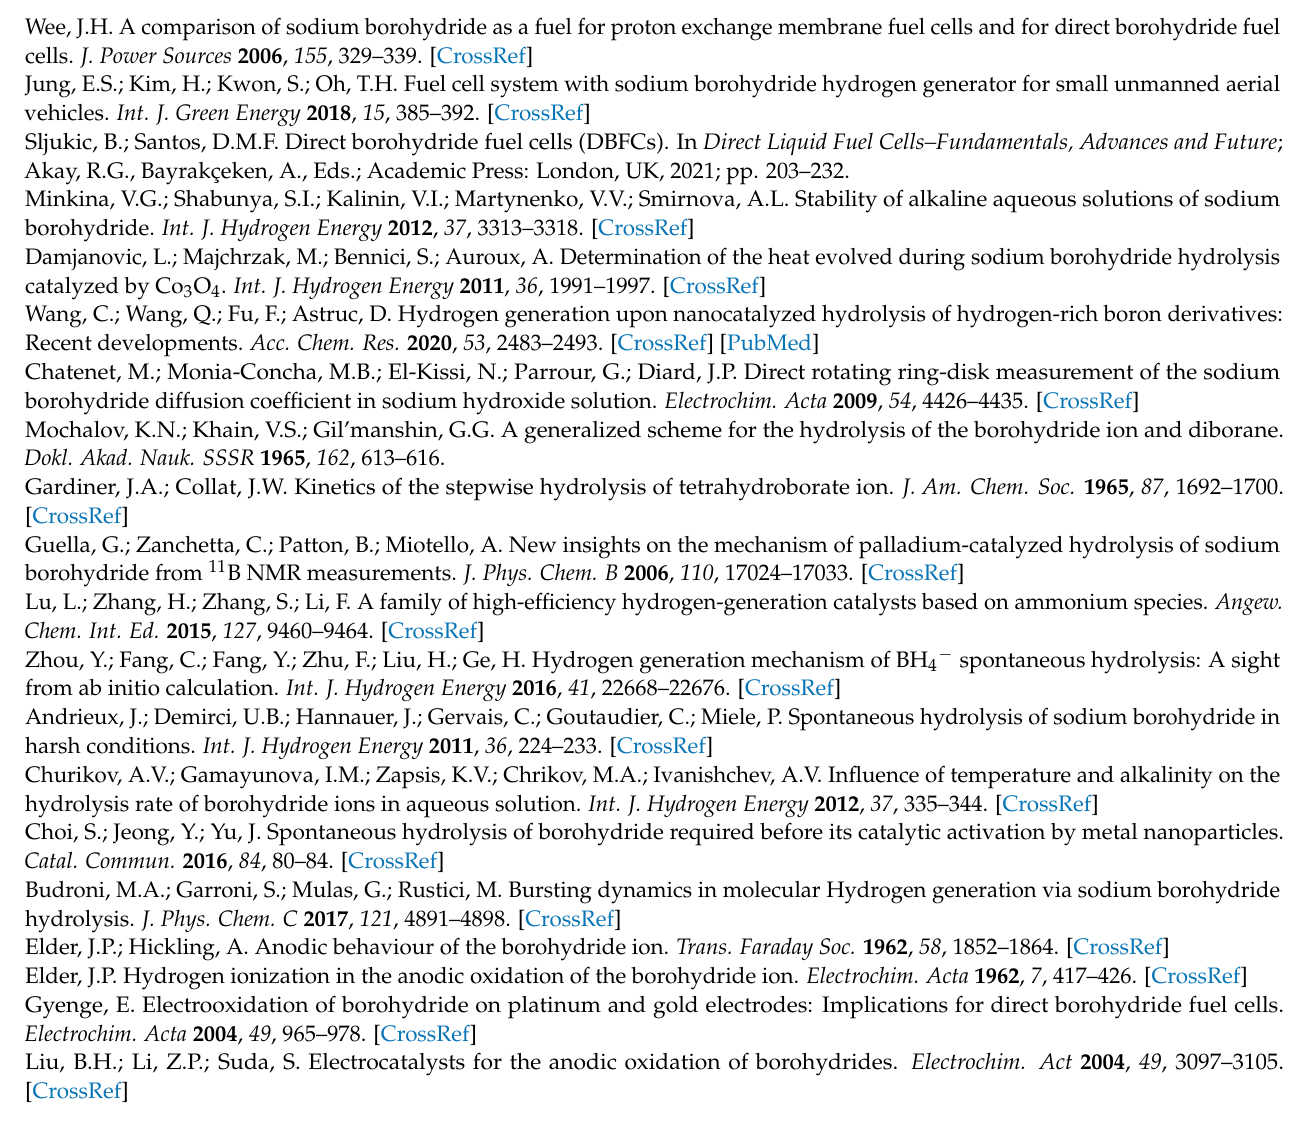
Figure S4: Deconvolution of the multiplet located between δ − 18.5 ppm and δ − 23.5 ppm for the − (1.32 M) hydrolyzed by 7.6 mL of alkaline 11 B NMR spectrum of the 10 mL DMF solutions of BH 4 (0.1 M NaOH) and catalyzed by Au after 48 and 72 h; Table S1: Results of the deconvolution made for the signal shown in Figure S4. The chemical shifts, Pascal’s triangles, and convergences are shown; the mol files of the structures are presented in Figure